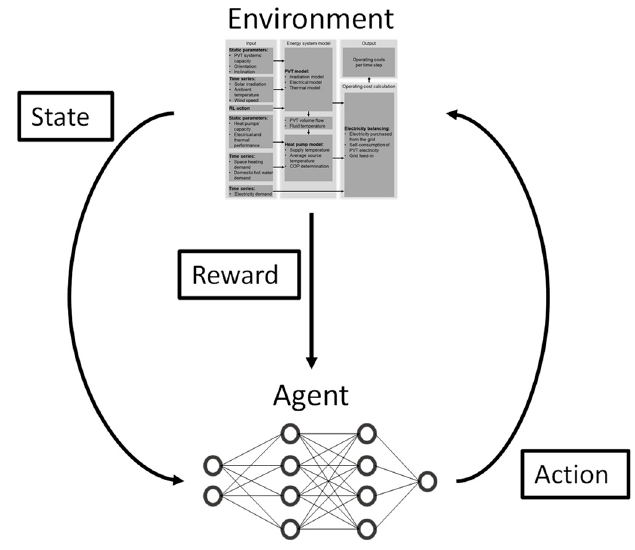
Figure 3. Main components and links of the reinforcement learning approach.